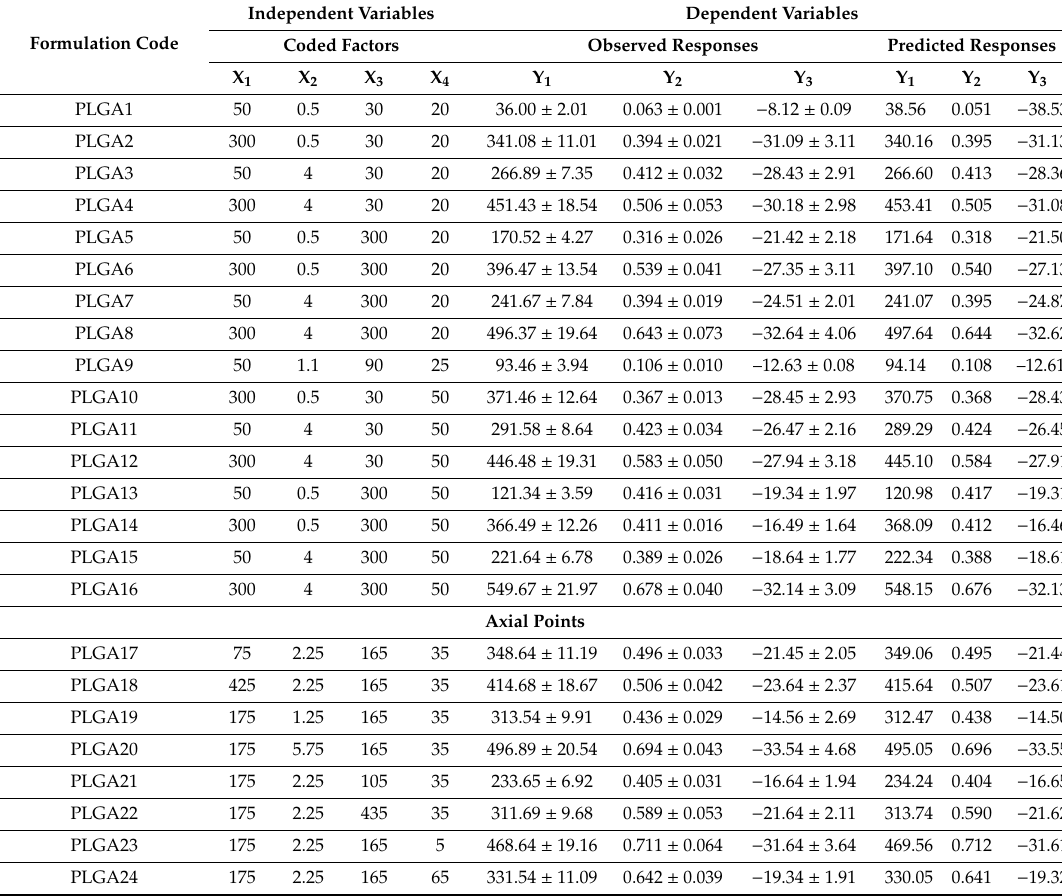
Table 2. Formulations recommended by “Design Expert” software, independent variables, and their